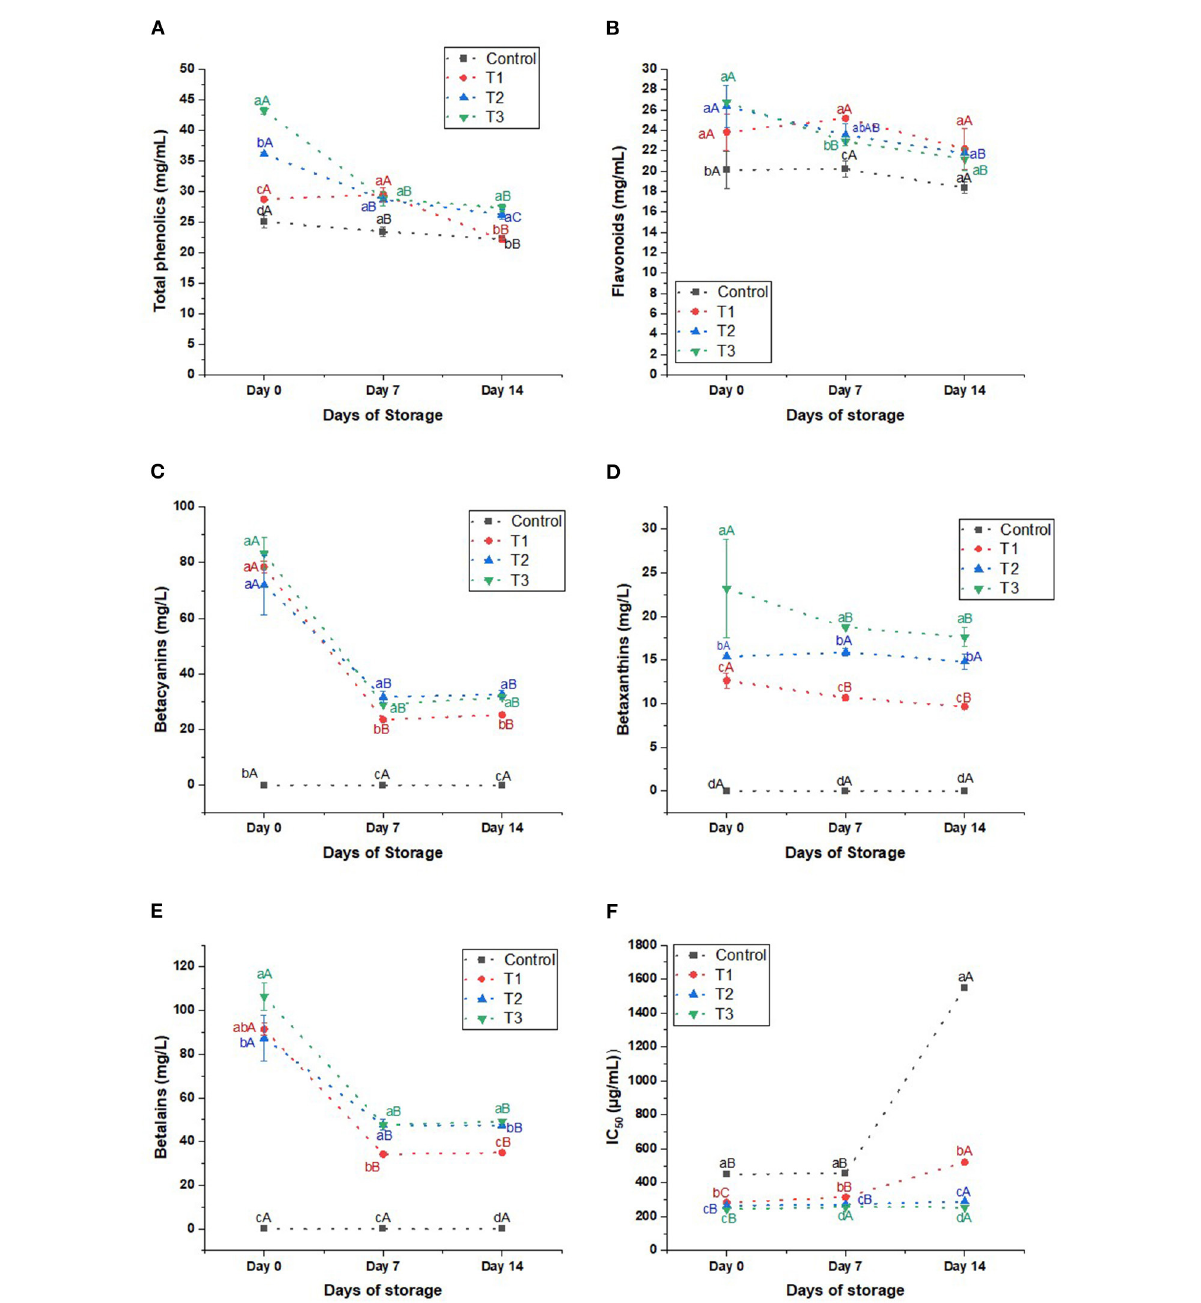
FIGURE5 (A) Total phenolics (mg/mL), (B) flavonoids (mg/mL), (C) betacyanins (mg/L), (D) betaxanthins (mg/L), (E) betalains (mg/L), and (F) IC 50 ( µ L/mL) of control beverage and beverages enriched with beetroot peel extracts at different concentrations. Means with different lowercase letters (a–d) on the same storage day are statistically different ( p < 0.05). Means with different uppercase letters (A–C) for each treatment during the different storage days are statistically different ( p <